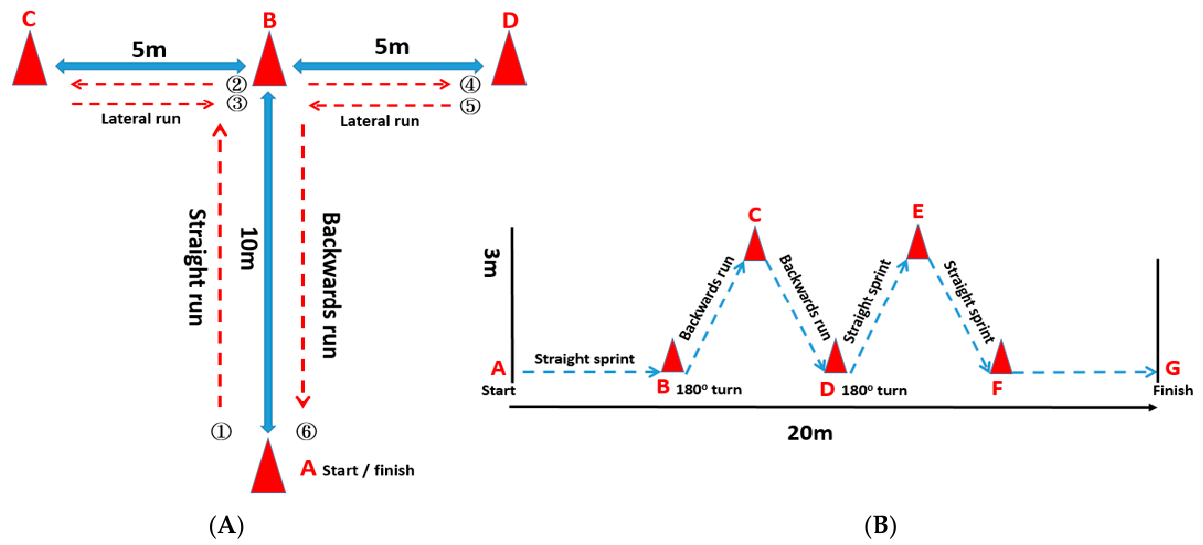
Figure 2. The procedure of the measurements at the competitive season and off-season. ( A ) The T-Test. ( B ) The planned agility test. The A → D and A → G represent the triangular cones used in the path of the T-Test and the planned agility test,